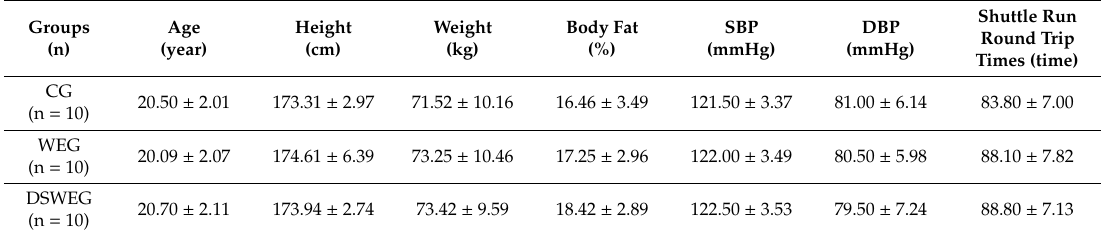
Table 1. General characteristics of